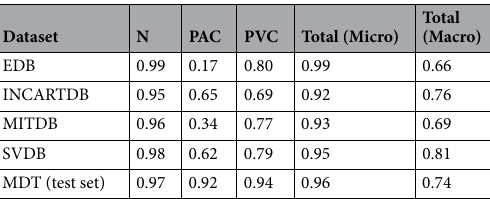
Table 4. Resultant test F1 scores for QRS classification.